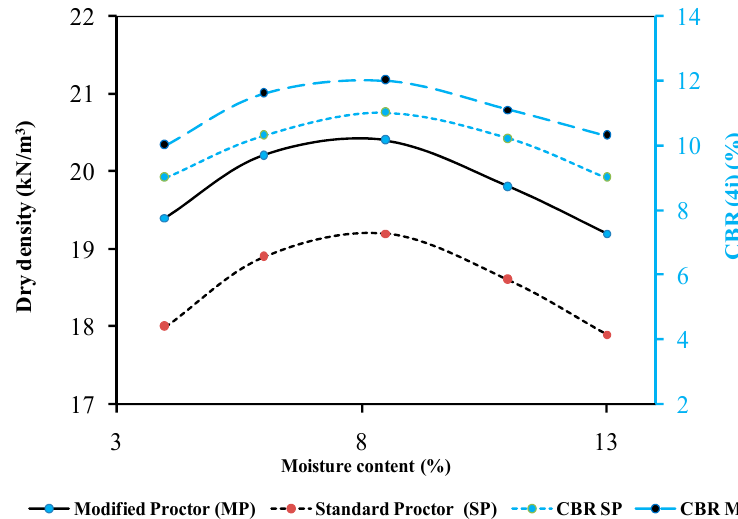
Figure 6. Proctor compaction energies of CMRW samples according to dry weight and CBR(4i).